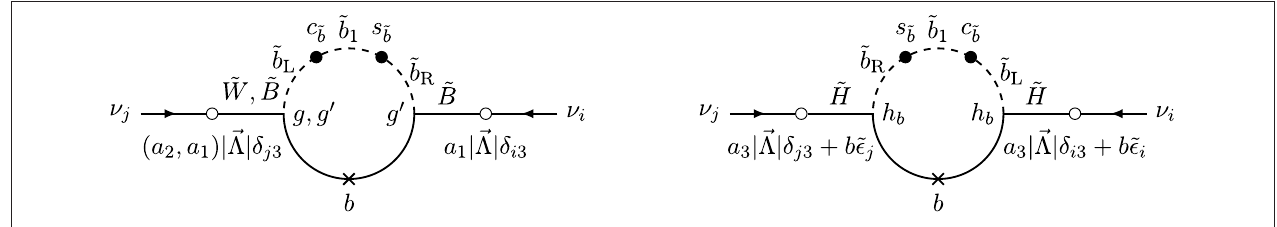
FIGURE 23 | Bottom–Sbottom diagrams for solar neutrino mass in the b- / R p model. Open circles correspond to small R-parity violating projections, full circles correspond to R-parity conserving projections and crosses indicate genuine mass insertions which flip chirality. h b reproduced from Diaz et al.